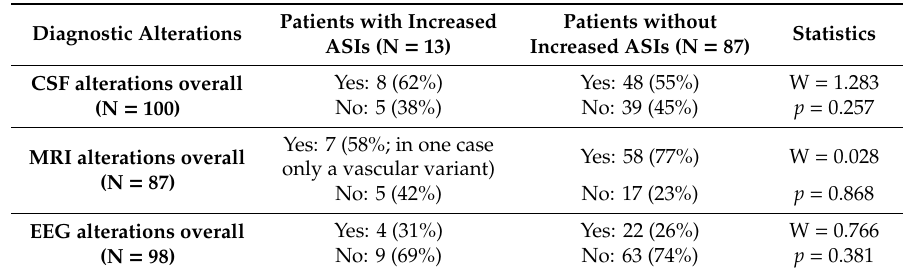
Table 3. Additional findings in patients with unipolar depression with and without increased antibody-specific indices